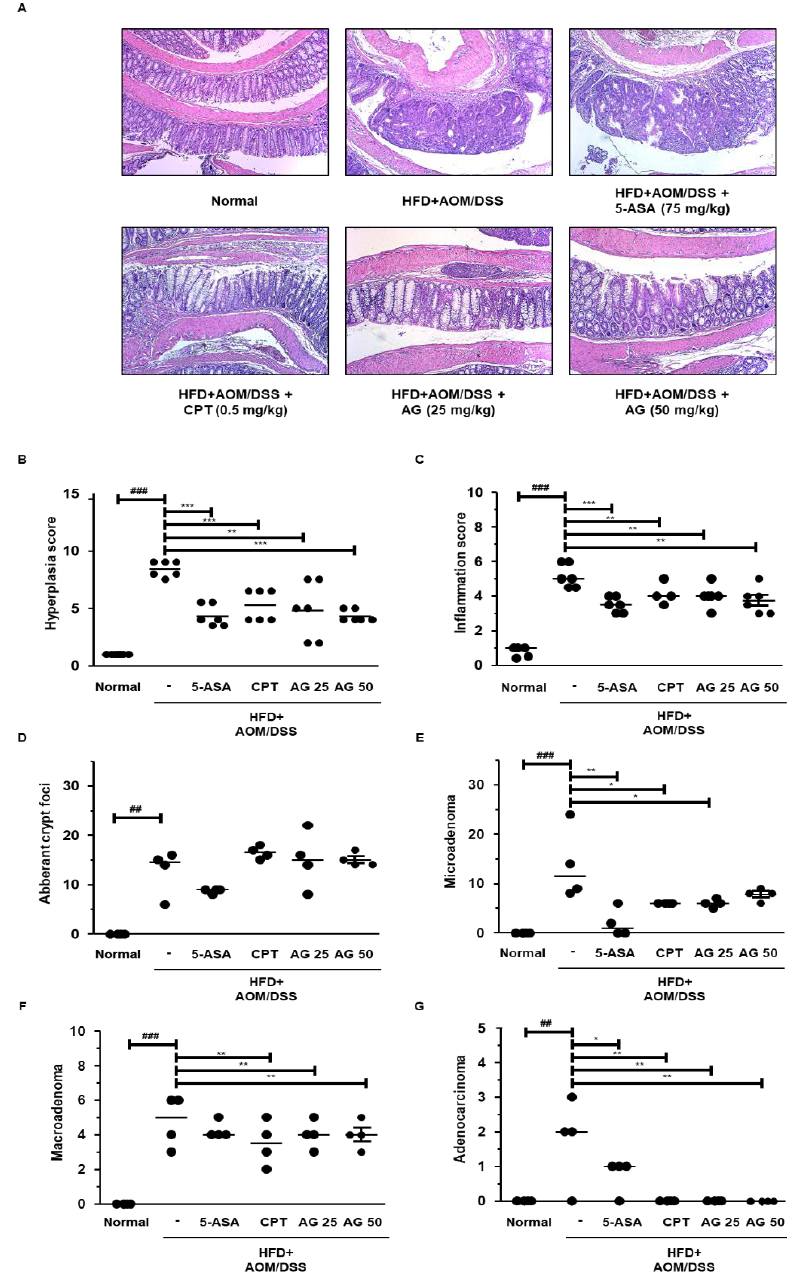
Figure 5. Effects of AG on histological analysis of the colorectal tissues in the HFD-propelled CAC mice model. ( A ) Representative portions of the colon tissues were stained by H&E (original magnification, 100×). ( B ) Hyperplasia score; ( C ) inflammation score; and the degree of ( D ) ACF, ( E ) microadenoma, ( F ) macroadenoma, and ( G ) adenocarcinoma were estimated. The values are the mean ± SD ( n = 10); ### P < 0.001 vs. normal group; * P < 0.5, ** P < 0.01, *** P < 0.001 vs. the HFD+AOM/DSS group; significant differences between the treated groups were determined by ANOVA and Dunnett’s post-hoc test.